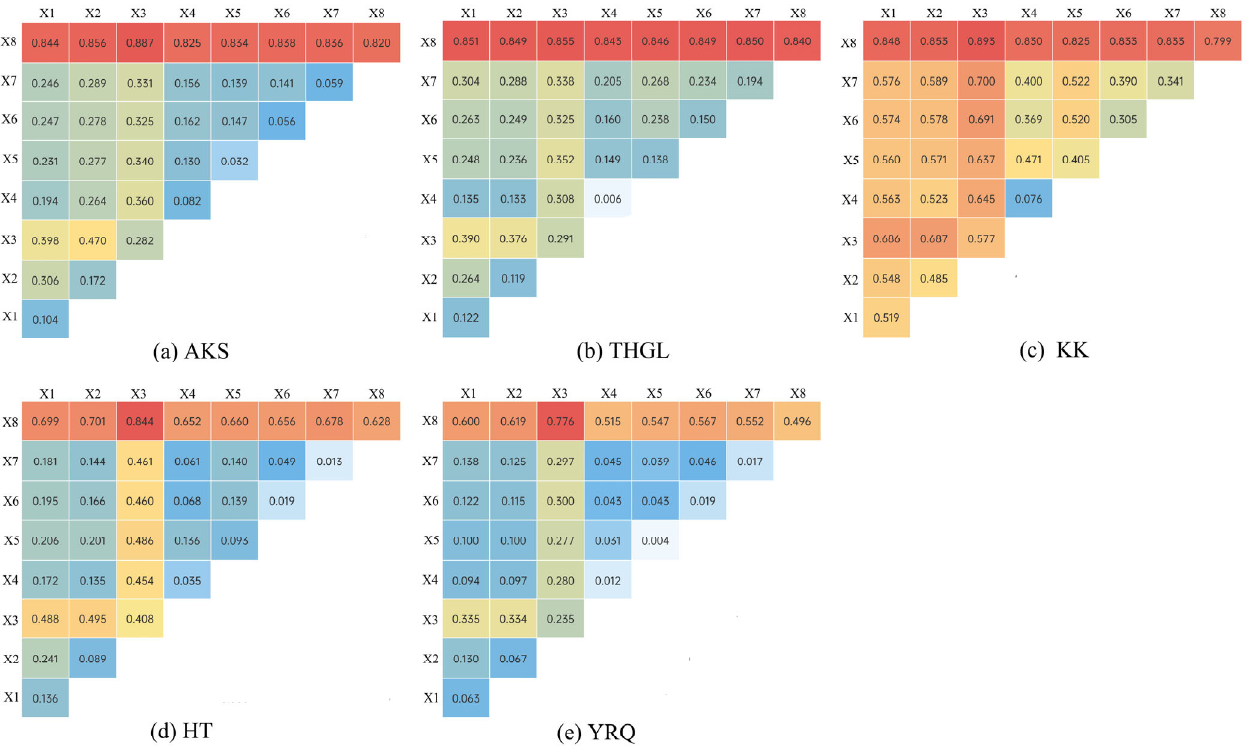
Figure 8. Factor interaction detection for ESV spatial differentiation. (figure ( a – e ): the two-factor interaction effects of each sub-basin in the study area; the color in the subplot tends to red for stronger correlation, and tends to blue for weaker correlation).